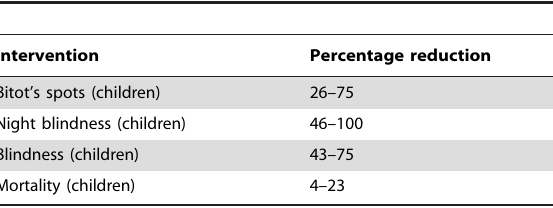
Table 1. Effectiveness of interventions in reducing VAD burden.